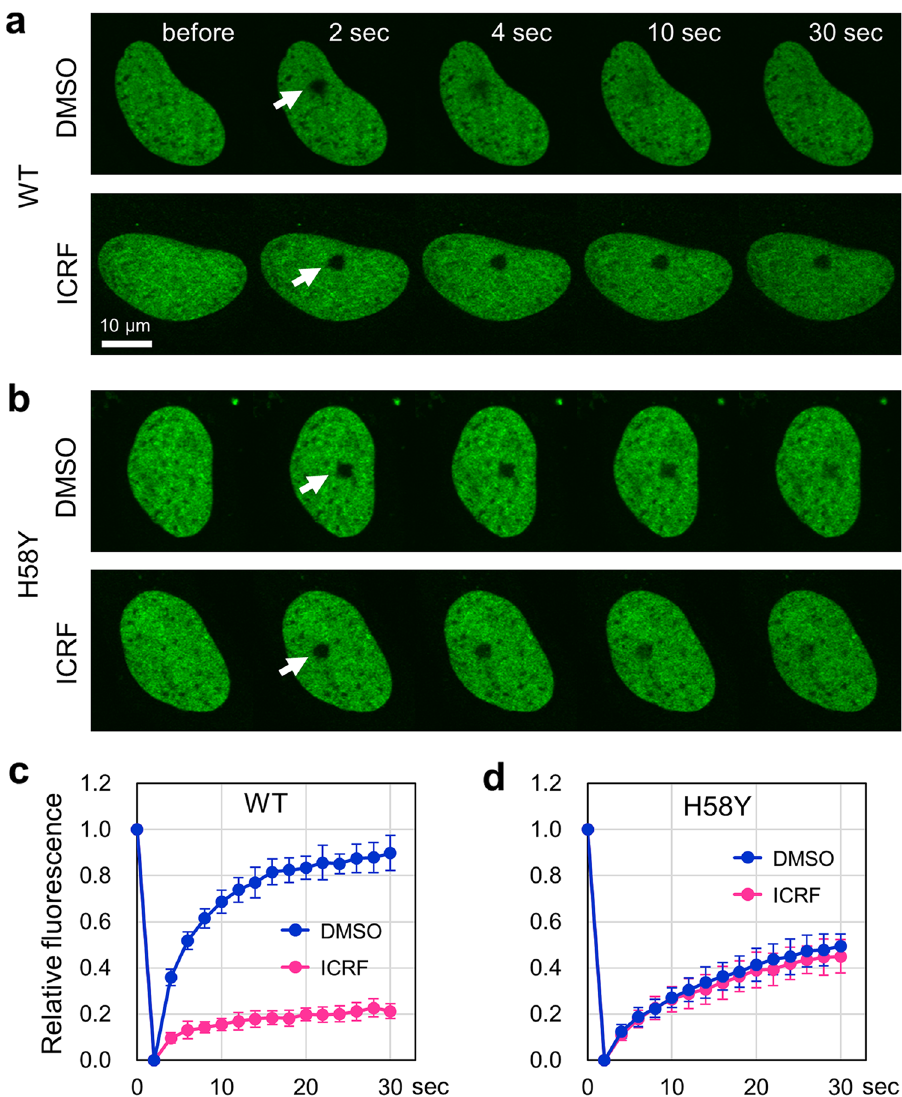
Figure 3. Insensitivity of EGFP-TOP2B H58Y to ICRF-187. ( a ) Representative images of FRAP analysis of EGFP-TOP2B WT in the presence of ICRF-187. Cells were treated with 20 µM ICRF-187 or DMSO (vehicle) for 1 h and subsequently subjected to FRAP analysis. White arrows indicate the area of photobleaching. ( b ) Representative images of FRAP analysis of EGFP-TOP2B H58Y in the presence of ICRF-187. Experiments with ICRF-187 were performed on EGFP-TOP2B H58Y as described in ( a ). ( c ) Quantitative analysis of fluorescence recovery of EGFP-TOP2B WT in the presence and absence of 20 µM ICRF-187 (n = 10; bars, SD). The mobile fractions were estimated to be 0.86 ± 0.06 (DMSO) and 0.20 ± 0.03 (ICRF). The t1/2 of fluorescence recovery was calculated to be 3.40 ± 0.34 s (DMSO) and 4.11 ± 1.75 s (ICRF). ( d ) Quantitative analysis of fluorescence recovery of EGFP-TOP2B H58Y in the presence and absence of 20 µM ICRF-187 (n = 10; bars, SD). The mobile fractions were estimated to be 0.55 ± 0.08 (DMSO) and 0.48 ± 0.06 (ICRF). The t1/2 of fluorescence recovery was calculated to be 9.54 ± 3.56 s (DMSO) and 8.21 ± 1.98 s